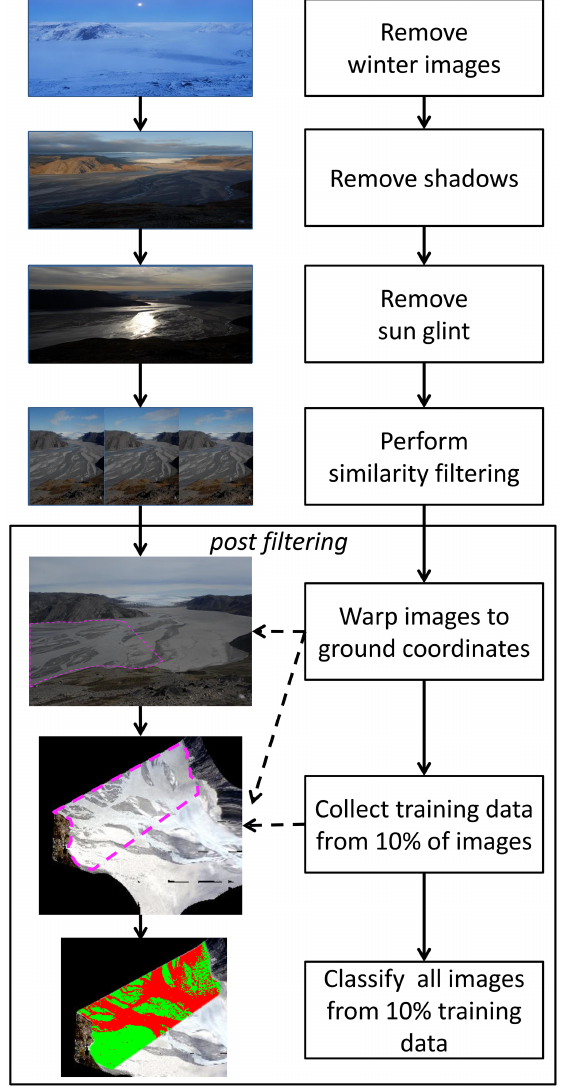
Figure 2. The processing steps required to extract W e from raw images are shown here. Every step until the final classification is completely automated, allowing for a vast reduction in processing time. Winter images were selected by a manual inspection of first and last observed open water flow. Shadowing was defined as when solar zenith angles were less than 65 ◦ or solar azimuth between 245 and 290 or 70 and 100 ◦ , and sun glint was defined as a ratio of pixel brightness and as a total pixel value threshold. The final classification as shown the bottom panel has some obvious errors, including speckling and some misclassifications of both water and non-water. As Fig. 4 shows, these filters did not significantly affect the temporality of the data, and about two-thirds of all days during the two-melt-season study duration are